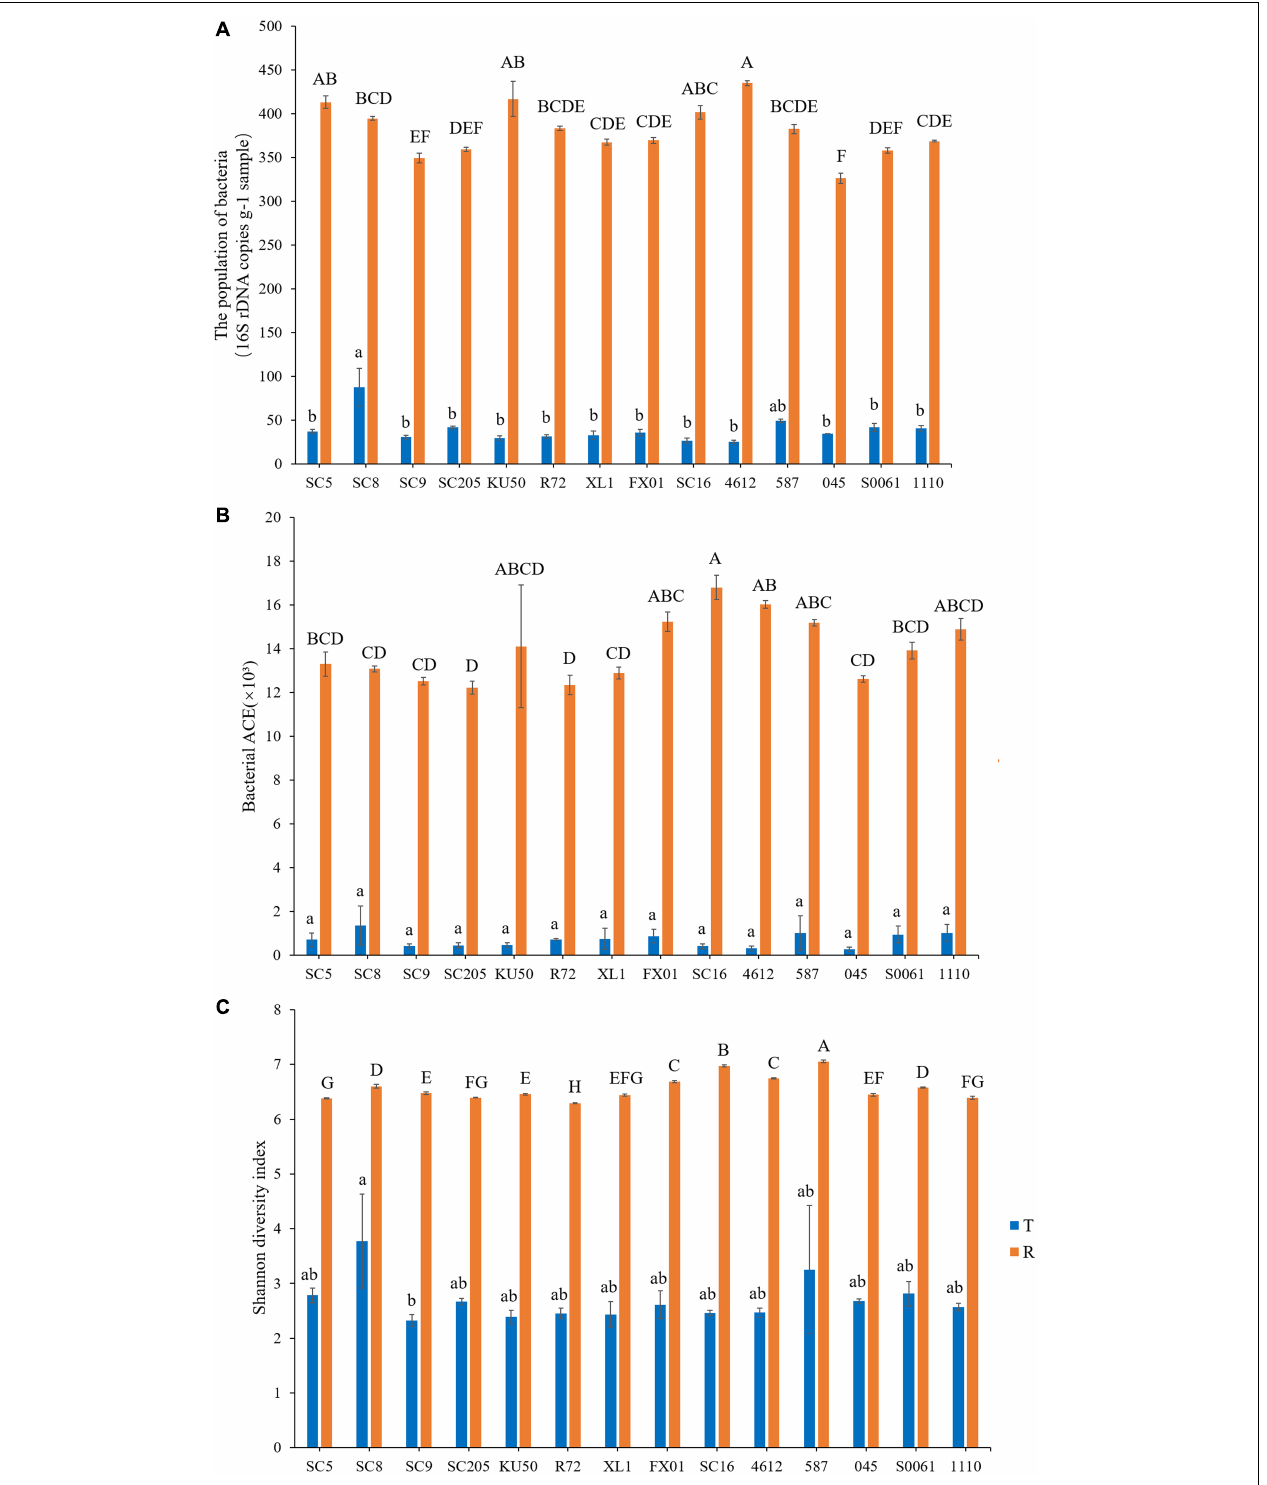
FIGURE 4 | Microbial population (A) , richness (abundance-based coverage estimator, ACE) (B) , and Shannon diversity (C) in the tuberous roots and rhizosphere soil of different cassava genotypes. Error bars represent standard deviations (SDs). Different lowercase letters and capital letters represent significant differences ( P < 0.05) within tuberous roots and rhizosphere soil according to Duncan test, respectively. T stands for tuberous roots; R stands for rhizosphere.